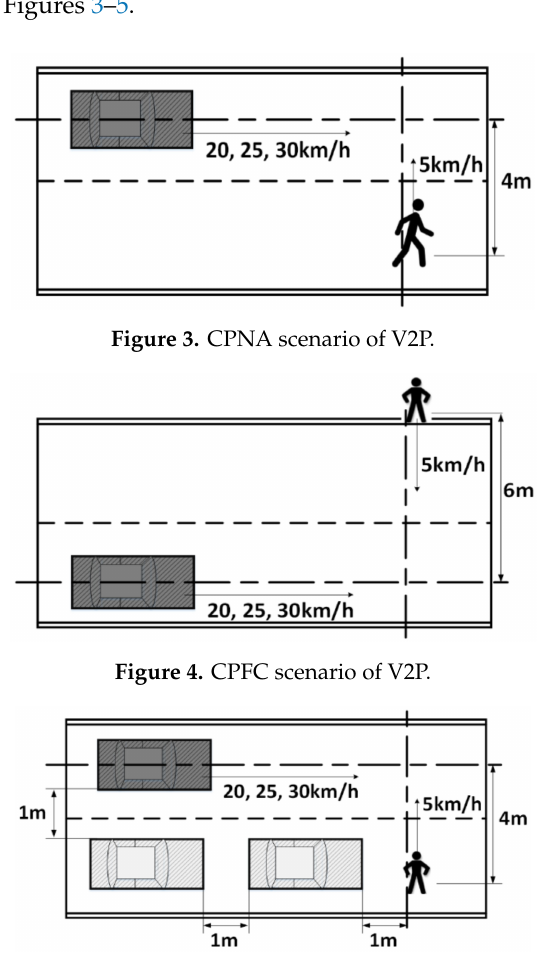
Figure 5. CPNC scenario of